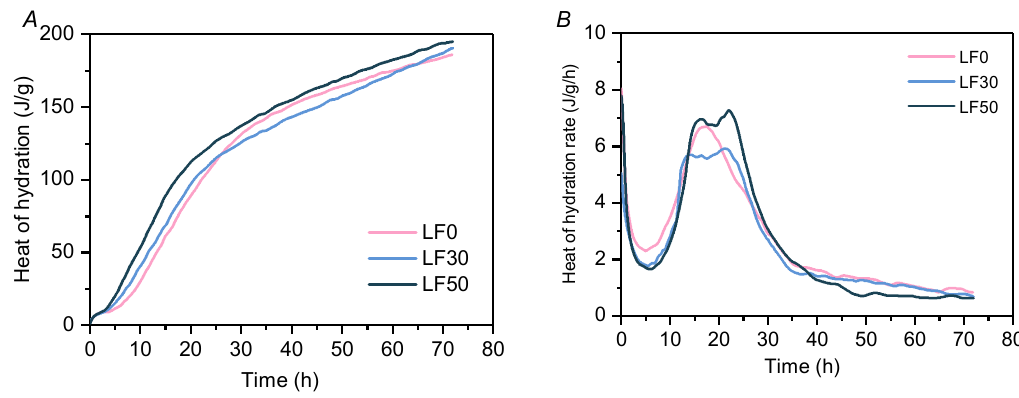
Figure 2. Heat of hydration and heat of hydration rate in LF-0, LF-30 and LF-50 mortar matrix. ( A ) Heat of hydration, ( B ) heat of hydration